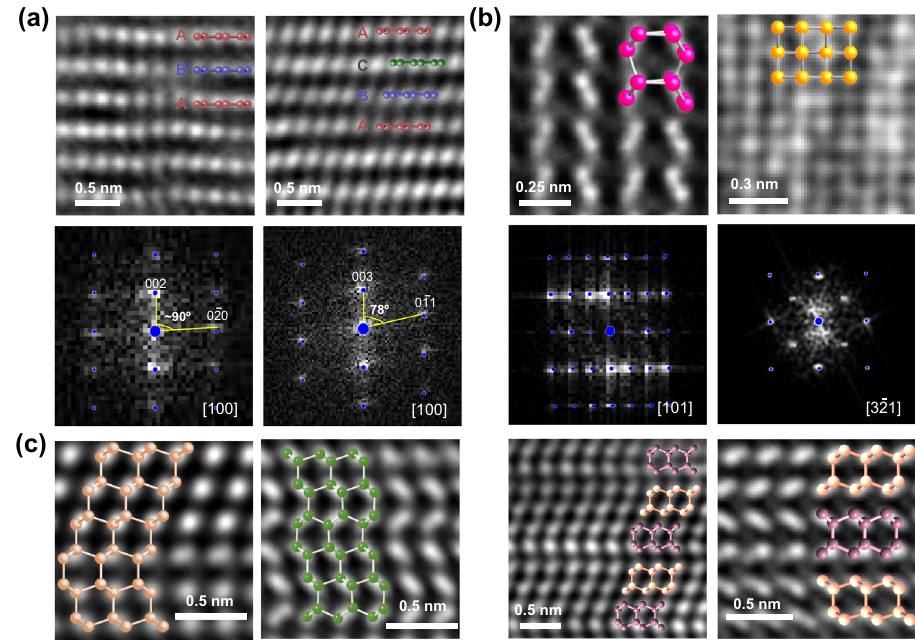
Fig. 3 High-resolution TEM images of metastable phases of carbon. a Orthorhombic-graphtie with AB ’ stacking pattern and rhombohedral-graphite with ABC stacking along with the experimental and simulated diffraction patterns (blue circles) 67 . b Hexagonal-diaphite and cubic-Diaphite along with the experimental and simulated diffraction patterns(blue circles) 68 . c Different combinations of stacking patterns resulting from the simultaneous inter-growth of hexagonal and cubic-diamond 79,106